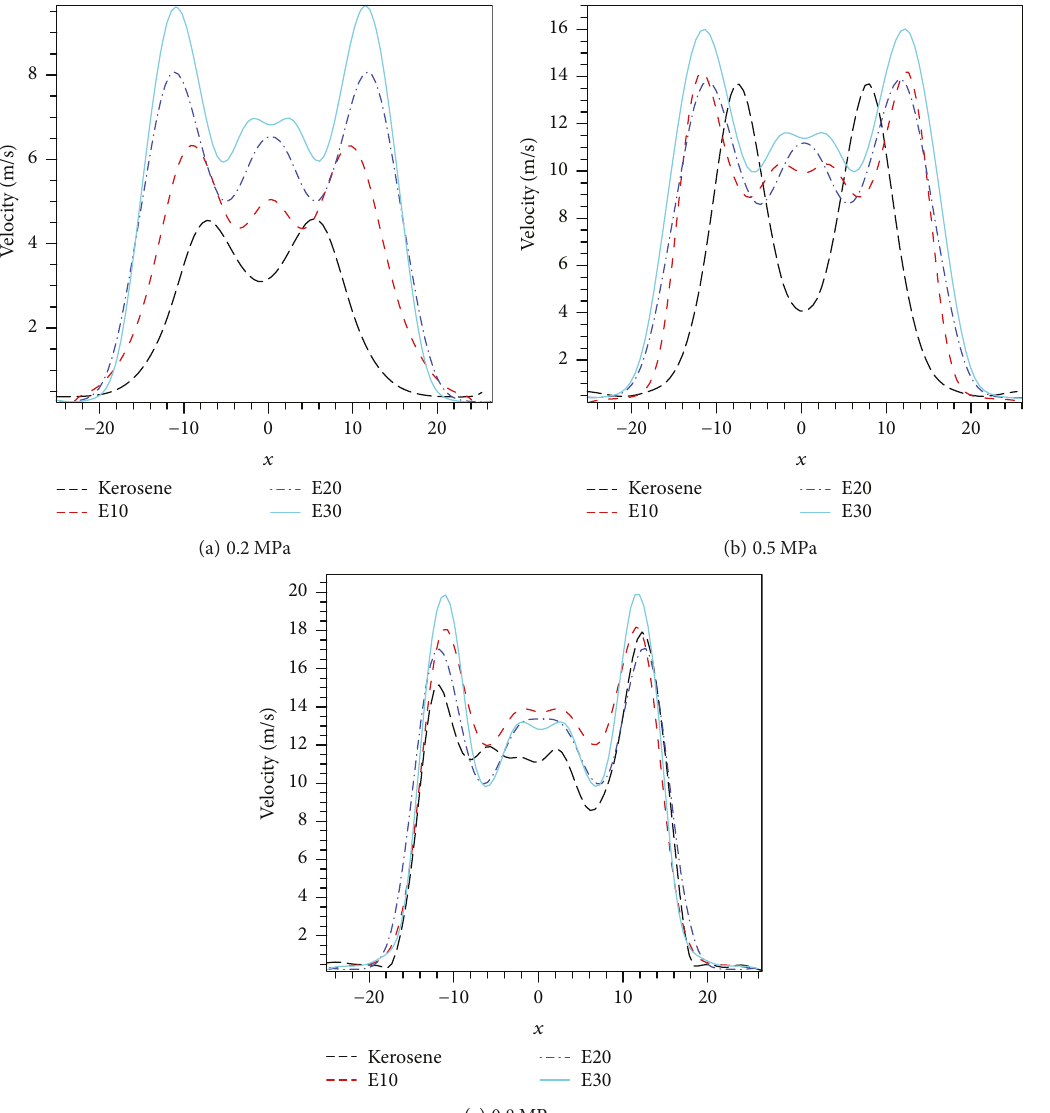
Figure 16: The velocity pro fi les of blended fuel at y = − 20mm under pressures of 0.2, 0.5, and